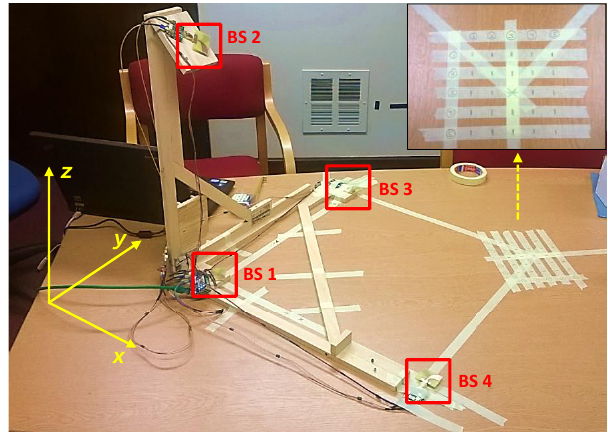
Figure 3: Measurement setup of the UWB localisation system placed on top of a table. The 5-by-5 matrix used to place the mobile station is shown in the